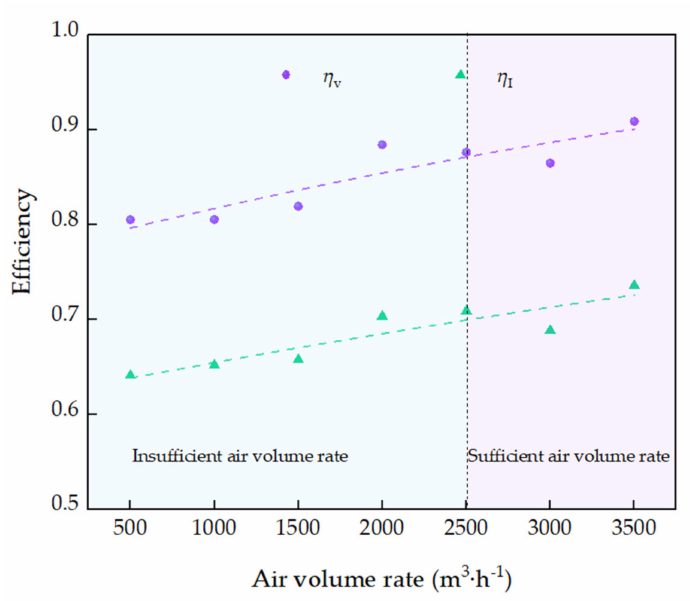
Figure 4. Effect of the air volume flow rate in the gas cooler on the compressor isentropic ( η I ) and volumetric ( η V )